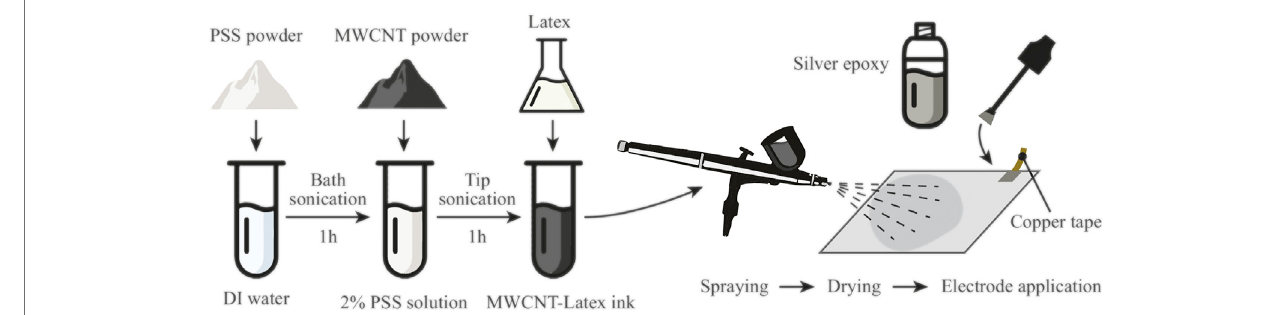
FIGURE 1 | Preparation of the MWCNT-latex ink and fabrication of the pressure-sensitive foam.